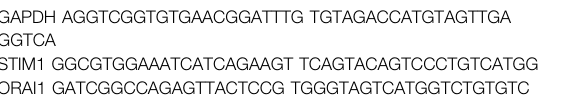
TABLE 1 | Primers for real-time polymerase chain reaction.